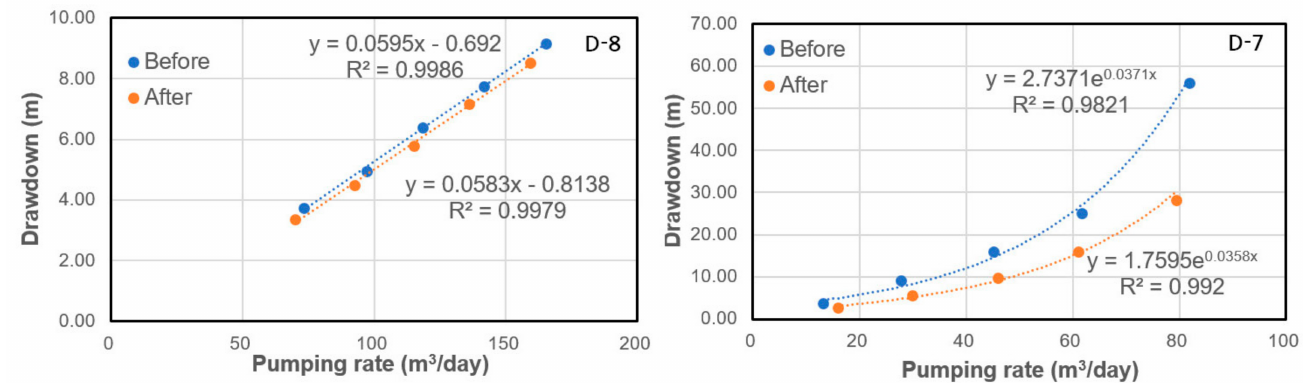
Figure 5. The relationship between the estimated one-day drawdown and pumping rate before and after surging in the D-8 and D-7 wells.